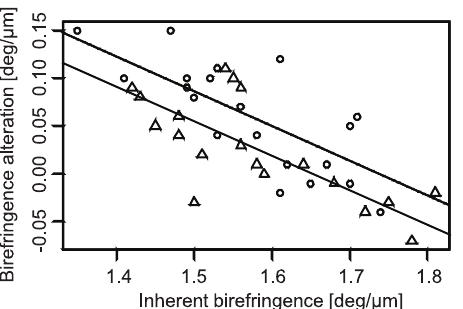
Figure 8. Birefringence alteration plotted against internet birefringence. Circles and rectangles indicate meridional and equatorial strain, respectively. The dashed and solid lines respectively represent regression curves of meridional and equatorial strains obtained by linear regression analysis which explains the birefringence alteration as a linear function of inherent birefringence and strain direction.